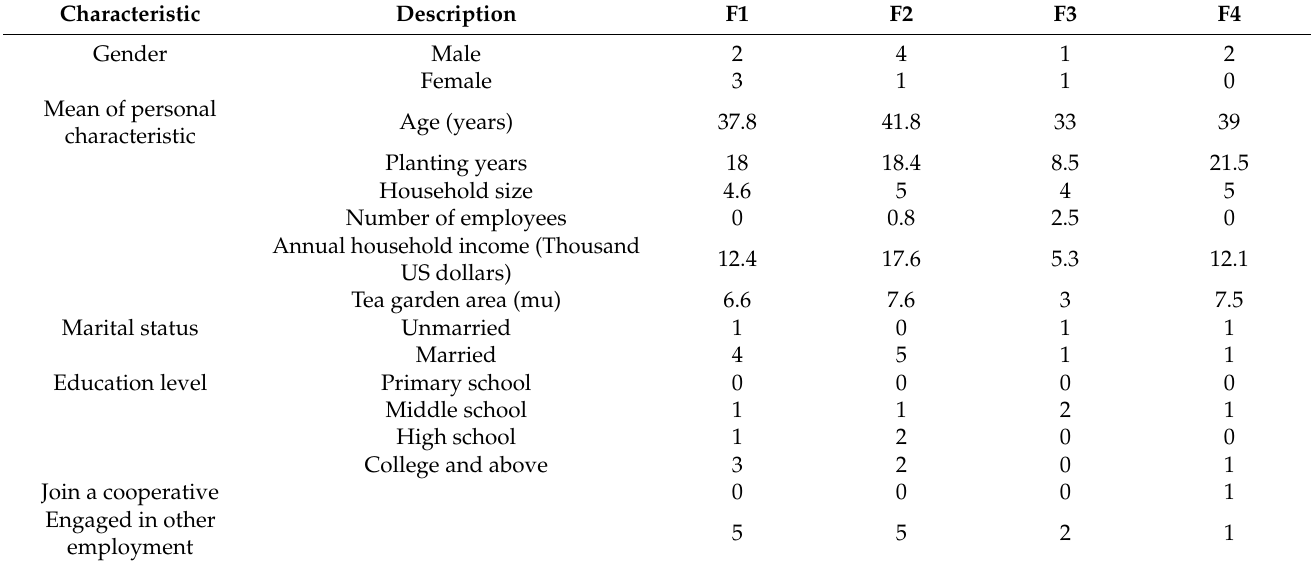
Table A2. The basic characteristics of tea farmers by factors.